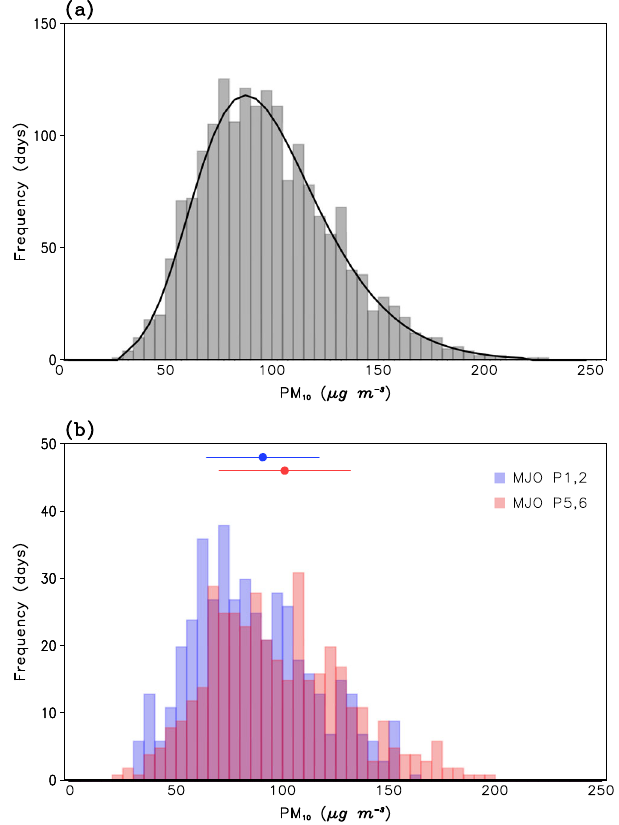
Fig. 3 | Frequency distribution of station-averaged PM 10 concentration. a Frequency distribution of all PM 10 observations with a bin size of 5 μ gm − 3 . Black linerepresentsthegeneralizedextremevaluedistribution.Un fi ltereddataareused. b Sameas( a )butforthePM 10 fromlag6 – 10daysduringMadden – JulianOscillation (MJO) phases 1 – 2 (blue) and 5 – 6 (red). Mean and one standard deviation are indi- cated at the top with dot and horizontal error bar,